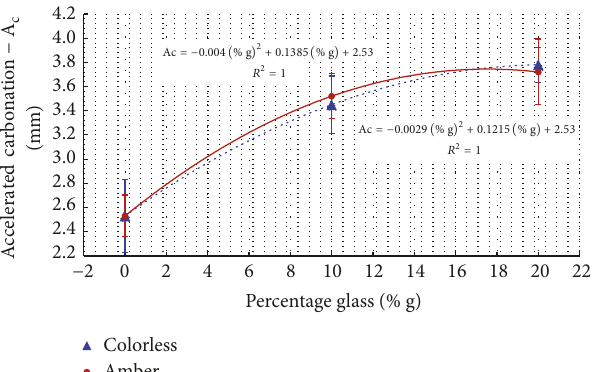
Figure 4: Alkali-silica reaction test